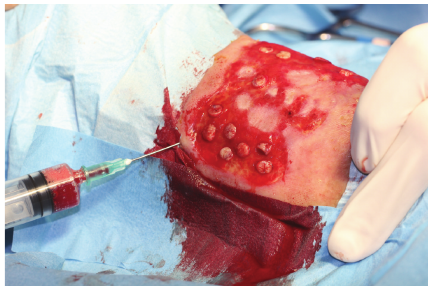
Figure 5: After 2 months we repeat intervention in areas not treated the first time. You can see the islands of reepithelialization of the previous treatment.